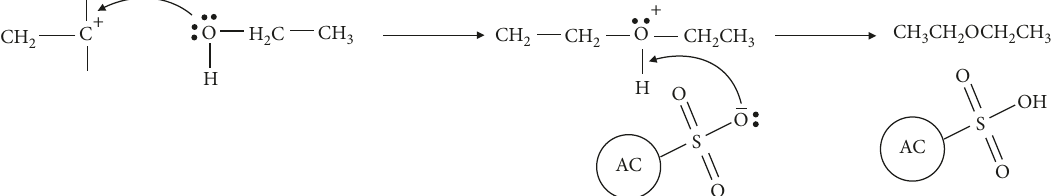
Figure 7: The mechanism of ethanol dehydration to diethyl